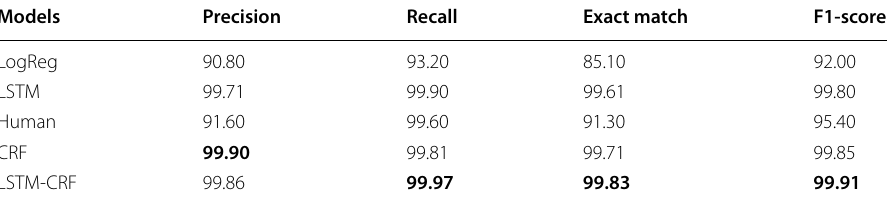
Bolded text is used to indicate the best performing values